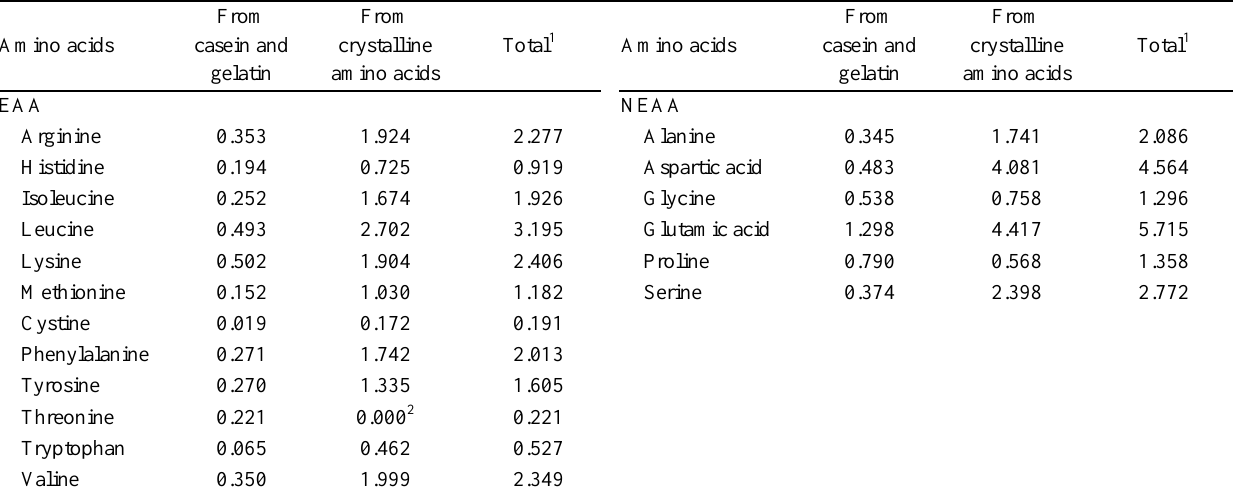
Table 2. Amino acid composition of the experimental diet (% of dry matter basis)